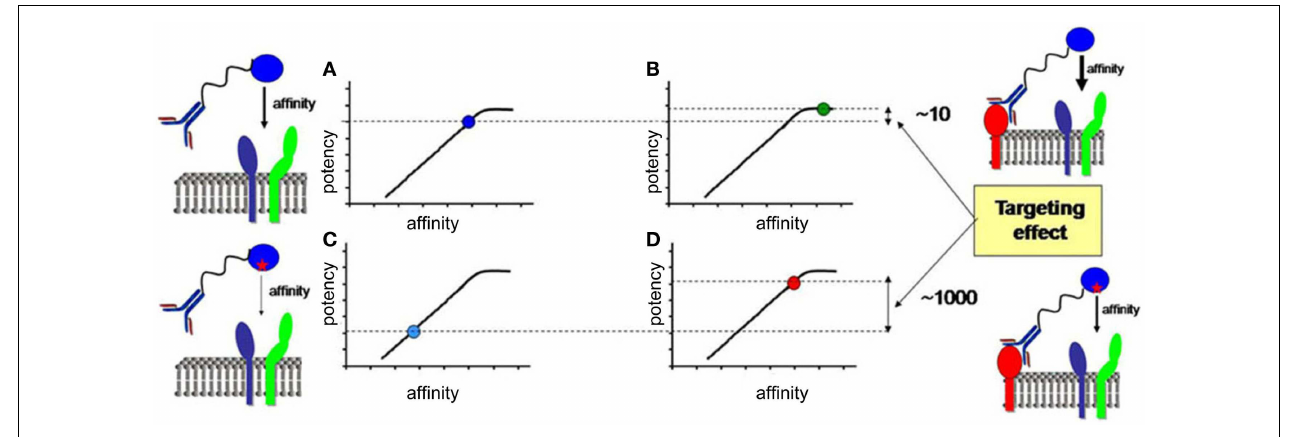
cytokine-receptor avidity translates into a modest increase of cytokine potency. (C,D) By introducing a mutation that decreases the affinity of the cytokine for its receptor, the activity of the mutated immunocytokine is now focused with a very high efficiency on target